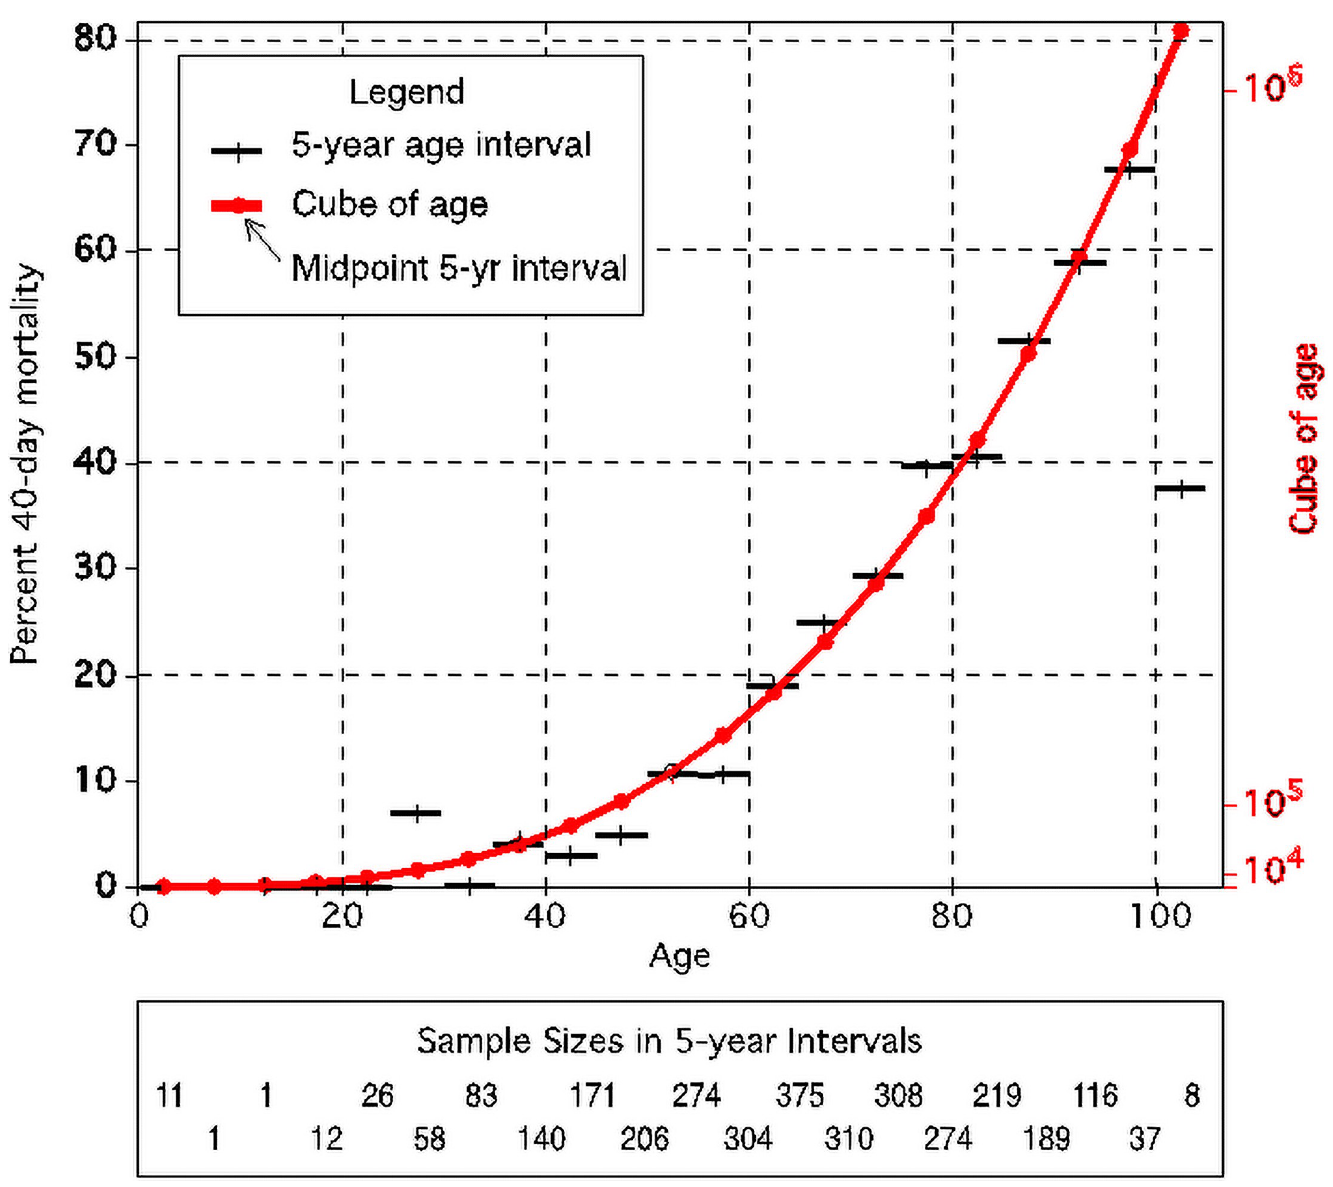
Fig 1. Relationship between age cubed and 40-day